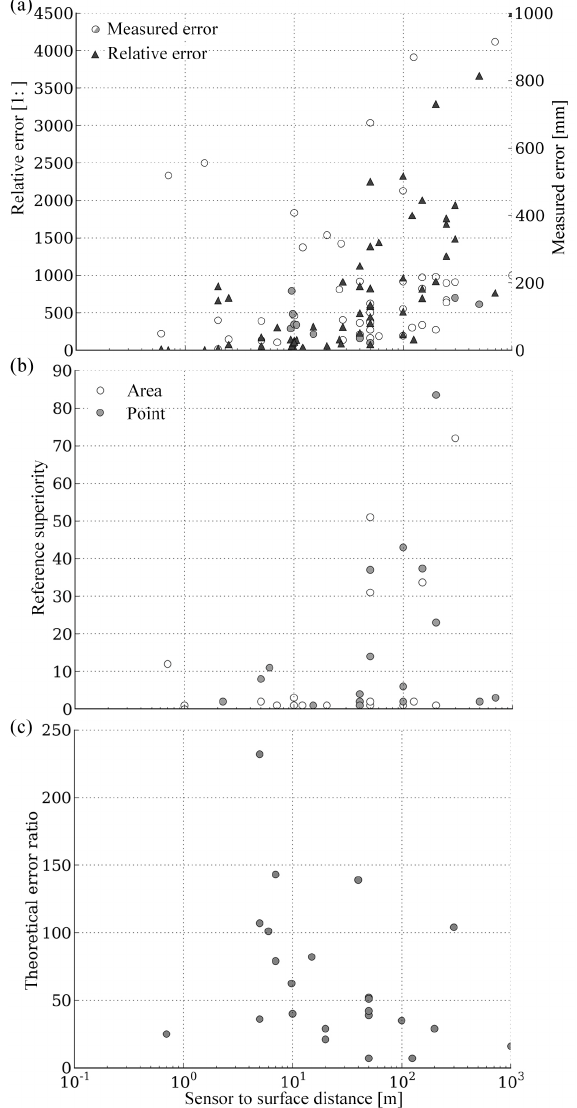
Figure 5. Performance of several error parameters in regard to the camera-to-surface distance. (a) Characteristics of measured error and relative error (N: 54; ID 1–3, 5–12 and 14–39 in Appendix A). For grey-coloured points GCPs are measured in point cloud (in to- tal 9 times corresponding to the studies: ID 8, 11, 12, 28, 36 and 37 in Appendix A) and for white points GCPs are measured in images (corresponding to the remaining studies) for model transformation. (b) Superiority of the reference data (N: 33), which is calculated as ratio between measured error and error of the reference. Area-based (ID 5–7, 12, 15, 17, 22, 25, 26, 30 and 32 in Appendix A) and point- based (ID 2, 3, 8, 9, 20, 24, 28–30, 33, 35 and 37 in Appendix A) reference measurements are distinguished. (c) Theoretical error ra- tio, considering the theoretical and measured error, to illustrate SfM photogrammetry performance in field applications (N: 23; ID